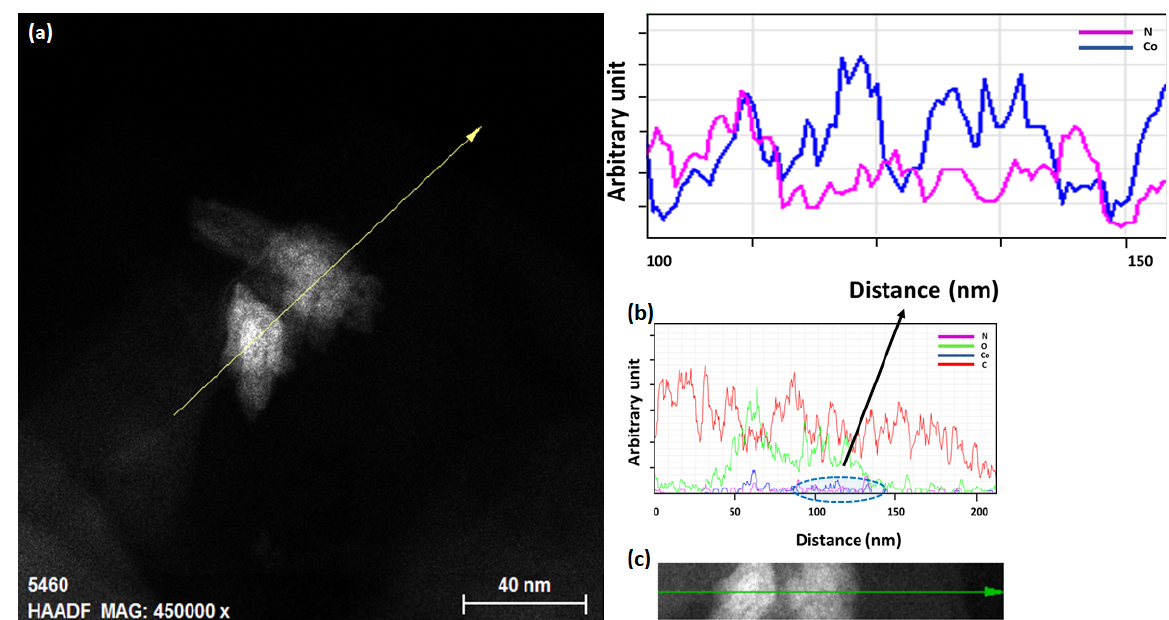
Figure 5. STEM-HAADF-EDS line scan analyses of Co-Por functionalized GNSs: ( a ) STEM-HAADF micrograph on the chosen area where a line scan along the direction indicated by the yellow arrow was performed. ( b ) Corresponding STEM-EDS line scan spectrum showing the variation of the Nitrogen (in pink), Cobalt (in blue), Carbon (in red), and oxygen (in green) signal recorded along the scanning direction indicated by the green arrow in ( c ). ( c ) Zoom of the analyzed area indicated by the yellow arrow in ( a ).